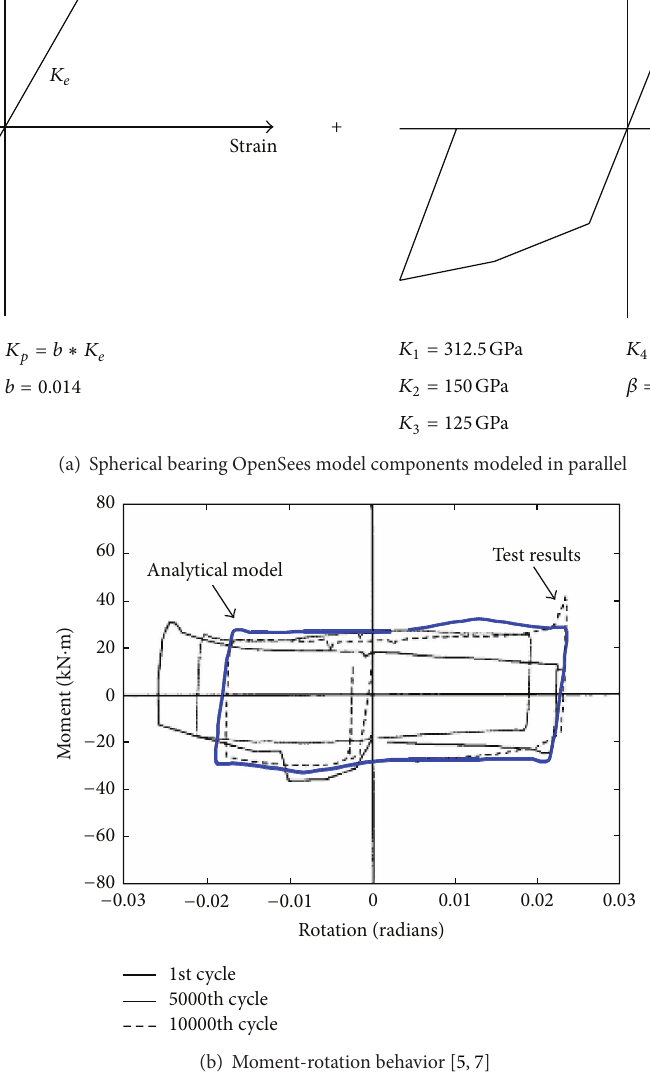
Figure 6: Spherical bearing